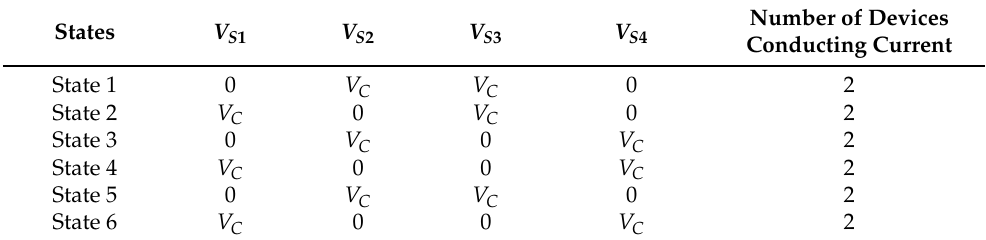
Figure 3. Full-bridge SM: ( a ) positive state, ( b ) zero state, ( c ) negative state, and ( d ) blocking state. Table 4. FB-SM device blocking